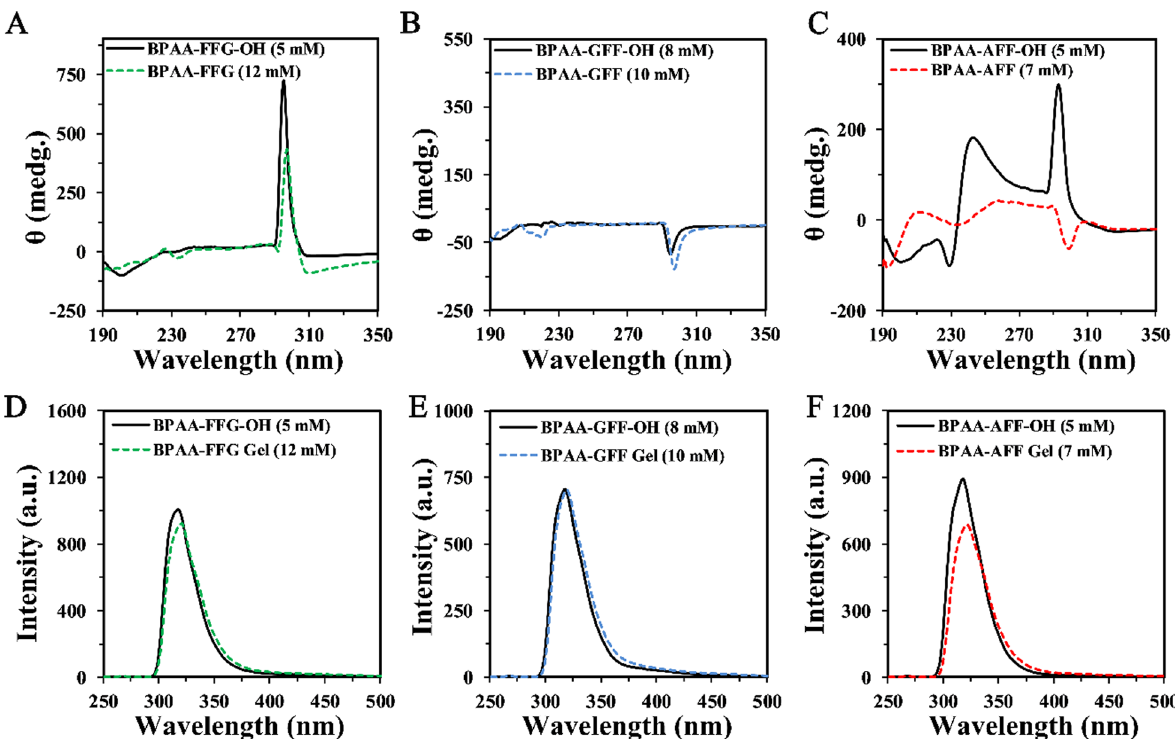
Fig. 3 A – C CD spectra of sol-FFG, sol-GFF sol-AFF and gel-FFG, gel-GFF, gel-AFF. D – F Fluorescence emission spectra of sol-FFG, sol-GFF, sol-AFF and gel-FFG, gel-GFF,